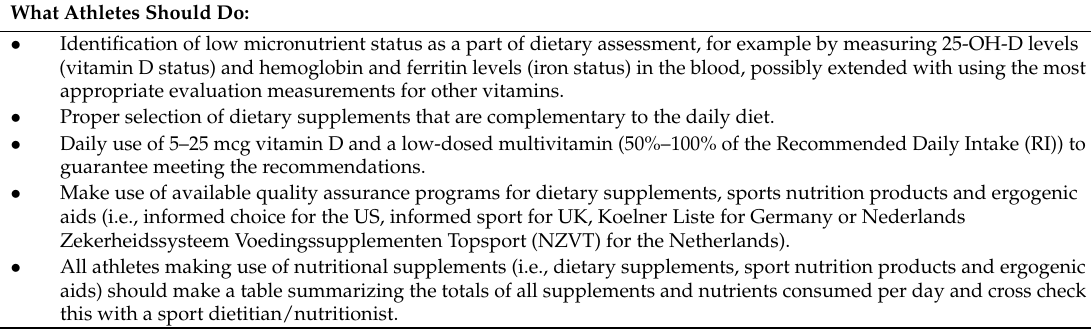
Table 6. Suggestions for supplement users: dos and